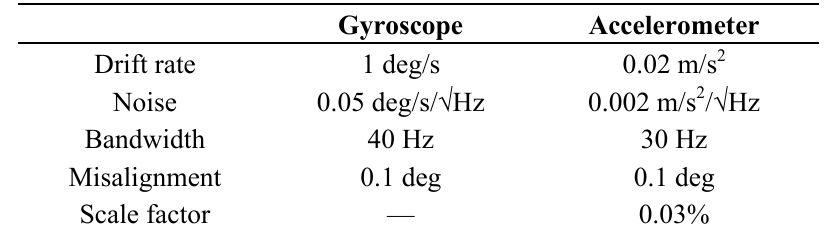
Table 2. Gyroscope and Accelerometer specification of Xsens MTi enclosure (Reproduced with permission from [37]).